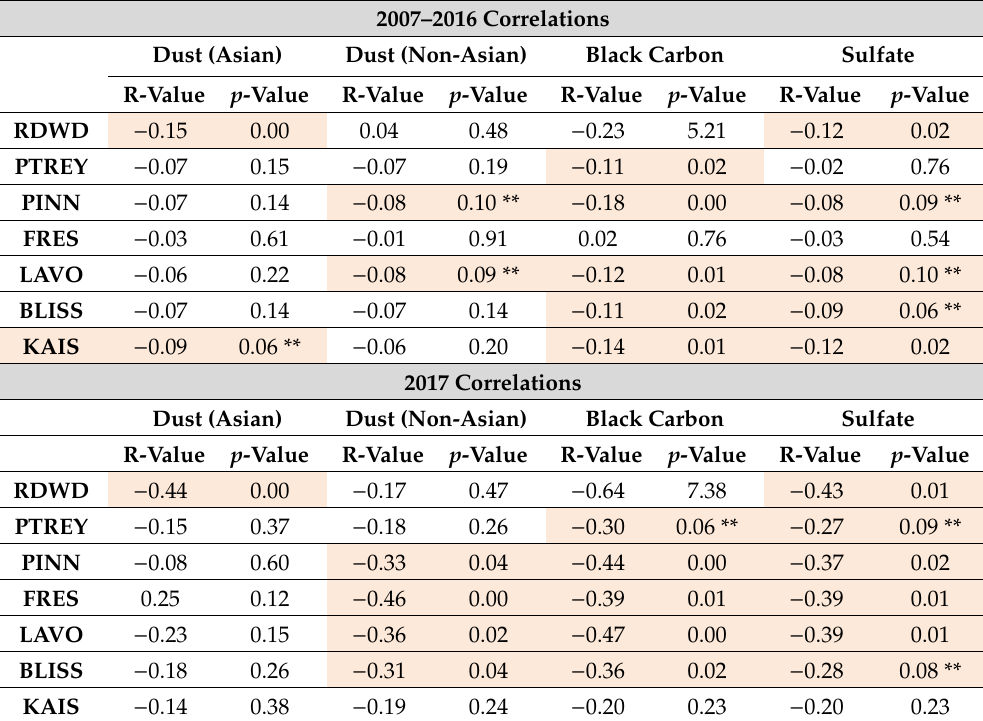
Table 2. Correlation Analysis between aerosols and precipitation at coastal (RDWD, PTREY, PINN), inland (FRES) and mountainous (LAVO, BLISS, KAIS) sites. Highlighted values are correlations (R-values) with p -values less than 0.05. The p -values between 0.05 and 0.1 is marked as